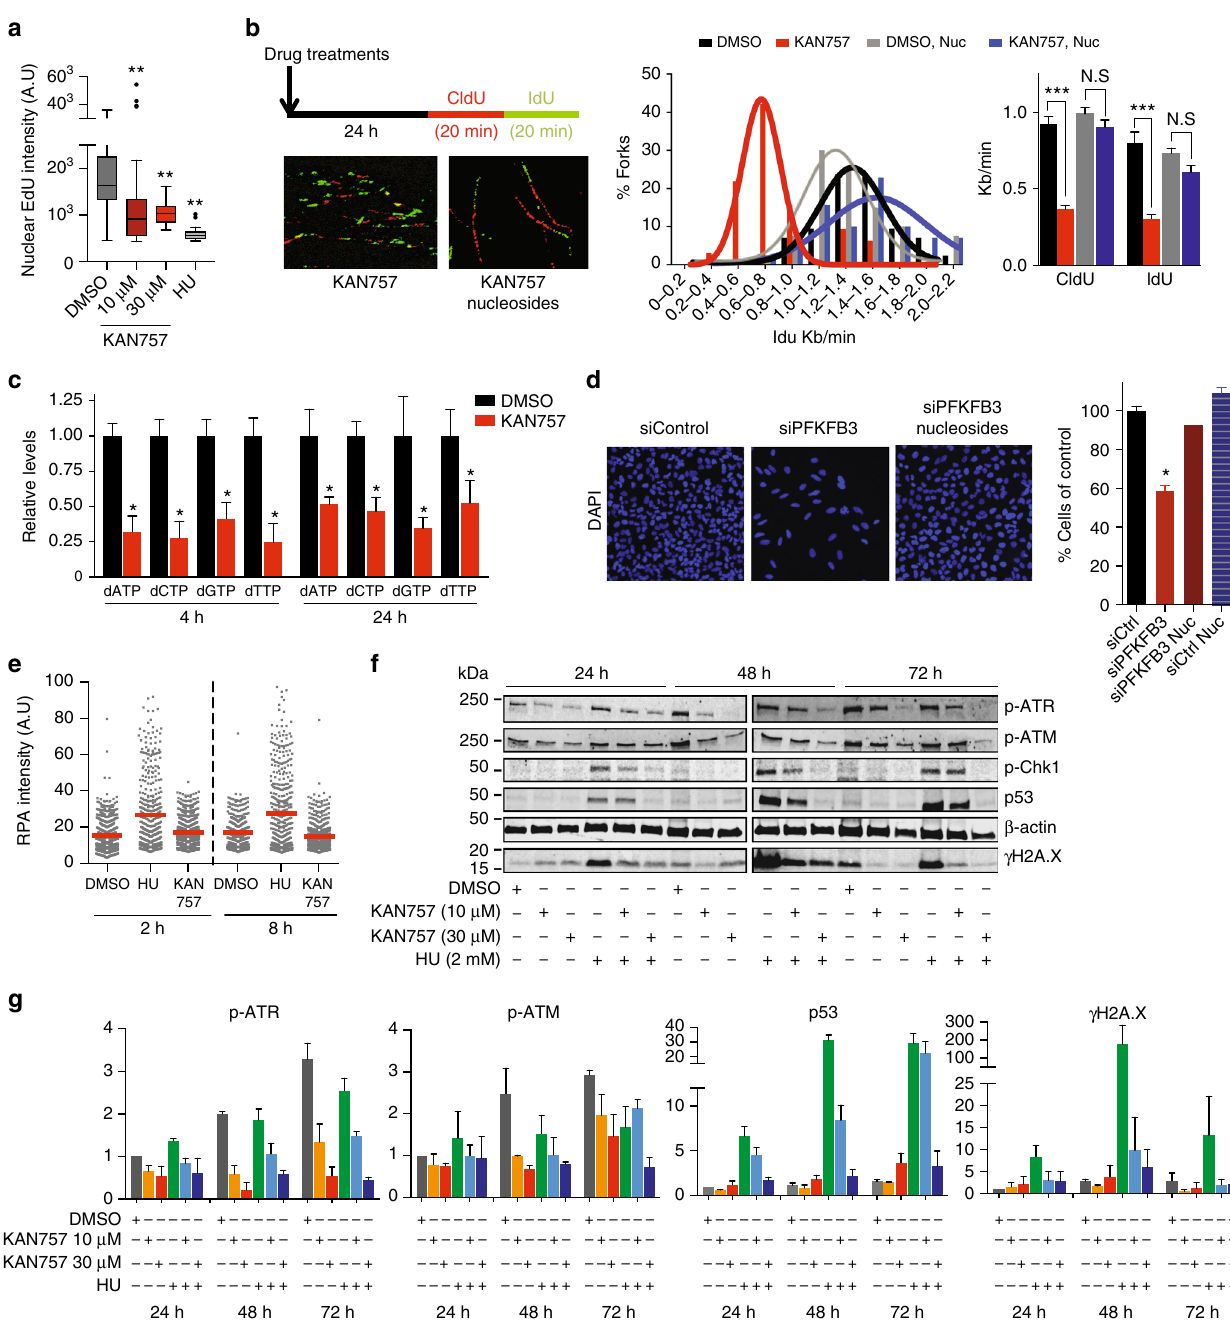
Fig. 6 Nucleoside supplementation restores proliferation of PFKFB3 inhibited cells. a Effects on DNA synthesis of U2OS cells treated with DMSO or indicated concentrations of KAN757 (4 h), pulsed with 10 μ M EdU for 40 min, followed by fi xation, fl uorescent labeling, and quanti fi cation in CellPro fi ler, >100 cells were analyzed per condition, n = 2. ** P < 0.01; one-way ANOVA analysis. b Schematic representation of the DNA fi ber assay and representative images of DNA strands incorporating CldU (red) and IdU (green) from U2OS cells that have received treatment with 10 μ M KAN757 supplemented with or without 30 μ M nucleosides. Graphs show the distribution of average fork speed and calculated mean fork speed for the indicated treatments ( n > 100 forks per condition). Data are displayed as means± SEM, n = 3. *** P < 0.001; Student ’ s t -test. c dNTP measurements of U2OS cells treated as indicated. Relative levels of dNTPs were calculated relative to DMSO. Data are displayed as mean ± SEM, n = 2. * P < 0.05; Student ’ s t -test. d Metabolic rescue of the proliferation of U2OS cells following 10 nM siControl or siPFKFB3 treatments and supplementation with or without 30 μ M nucleosides was assessed by DAPI staining and counting nuclei using CellPro fi ler. siControl cells are set as reference cells. Data are displayed as means ± SEM, n = 2. * P < 0.05; one-way ANOVA analysis. e Scatter dot plot representing the nuclear intensity of the fl uorescence levels of RPA32 in U2OS cells following treatment with DMSO or indicated inhibitors as quanti fi ed using CellPro fi ler. Lines represent mean fl uorescence, n > 500 cells/treatment. f Representative immunoblots (of n = 2) of U2OS cells treated with DMSO, KAN757 (10, 30 µ M) and/or HU (2 mM) for indicated time points. Bands correspond to whole cell extracts, β -actin was used as loading control. g Bar charts representing relative levels of phosphorylated ATR and ATM, p53 and γ H2AX in ( f ). Densitometric analysis was performed using Image Studio TM Lite Software. Signal intensity data were normalized against β -actin and then normalized to DMSO 24 h. Data are displayed as means± SD, n = 2 independent experiments. KAN757 =